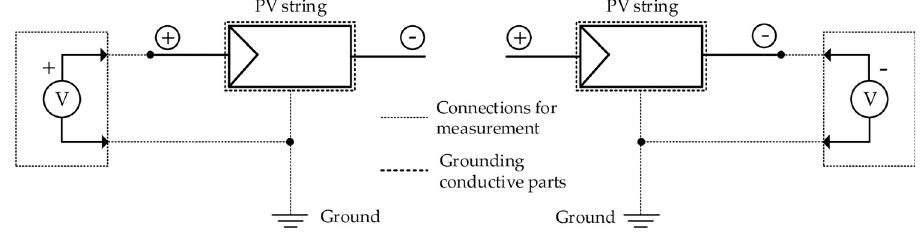
Fig 5. Measuring of leakage voltage of PV